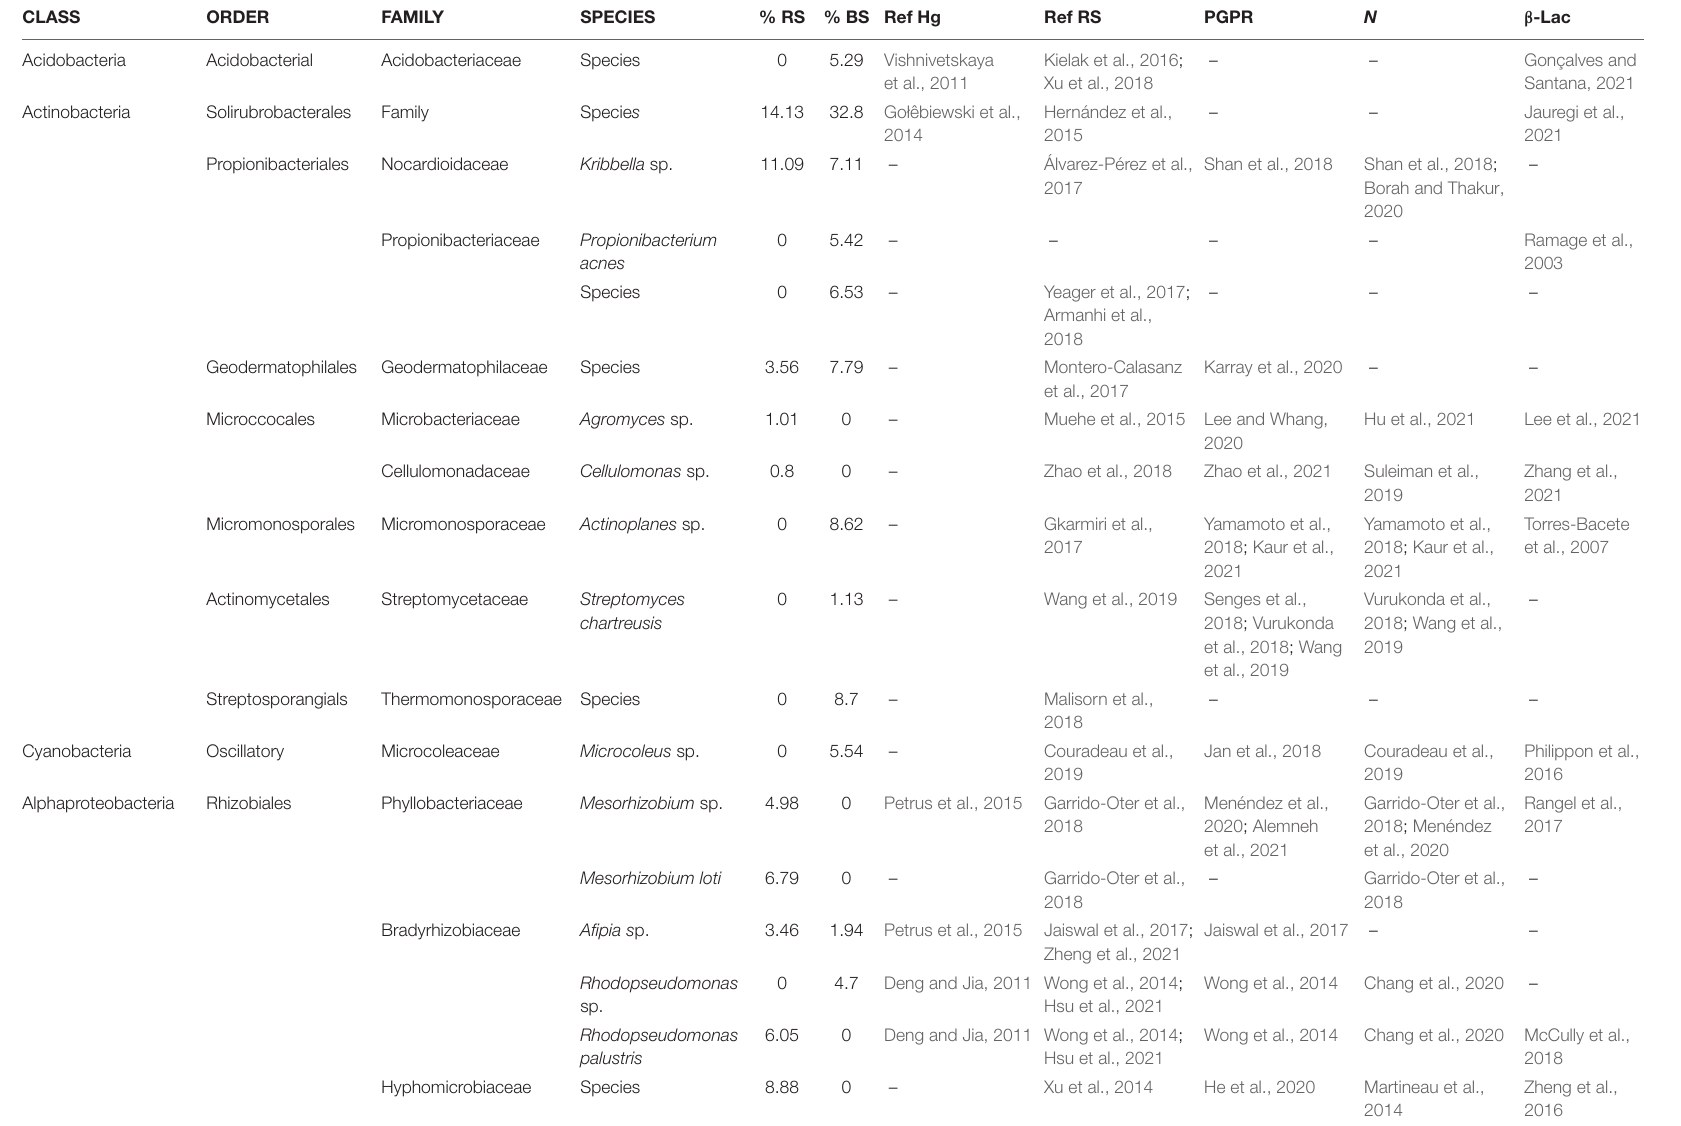
TABLE 1 | General table of bacterial taxonomic identification, together with their relative abundances in BS and